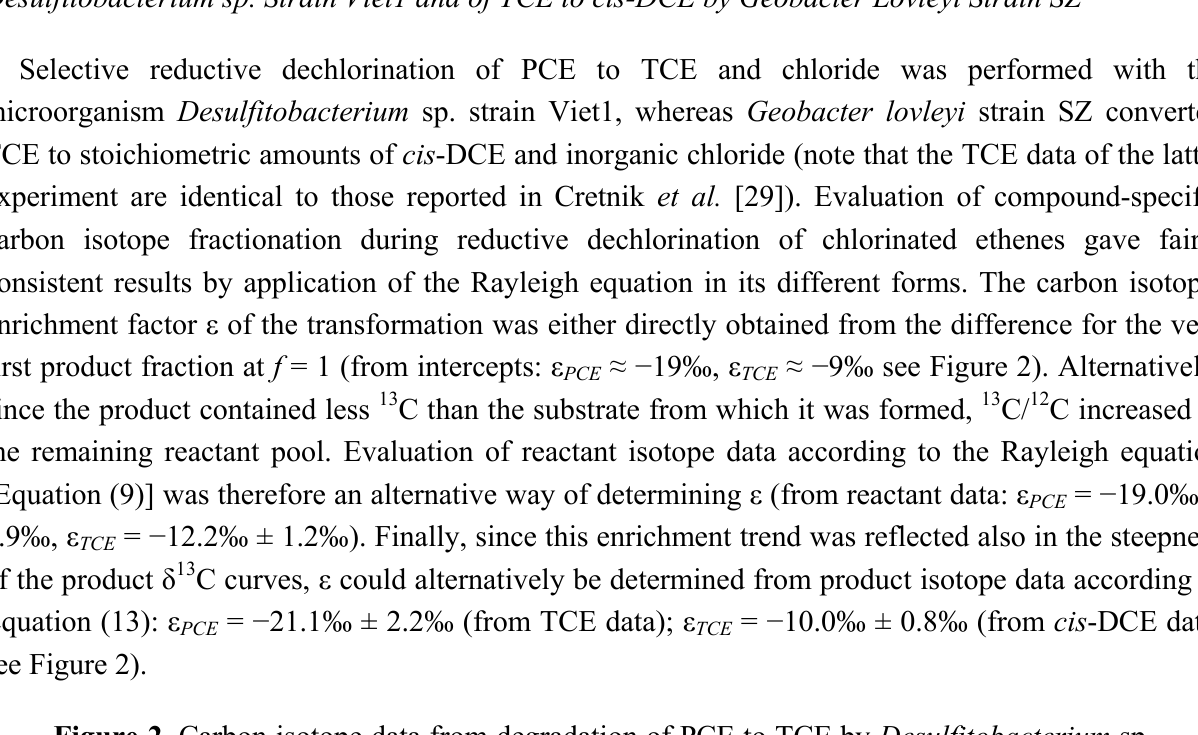
Figure 2. Carbon isotope data from degradation of PCE to TCE by Desulfitobacterium sp. strain Viet1, and of TCE to cis -DCE by Geobacter lovleyi strain